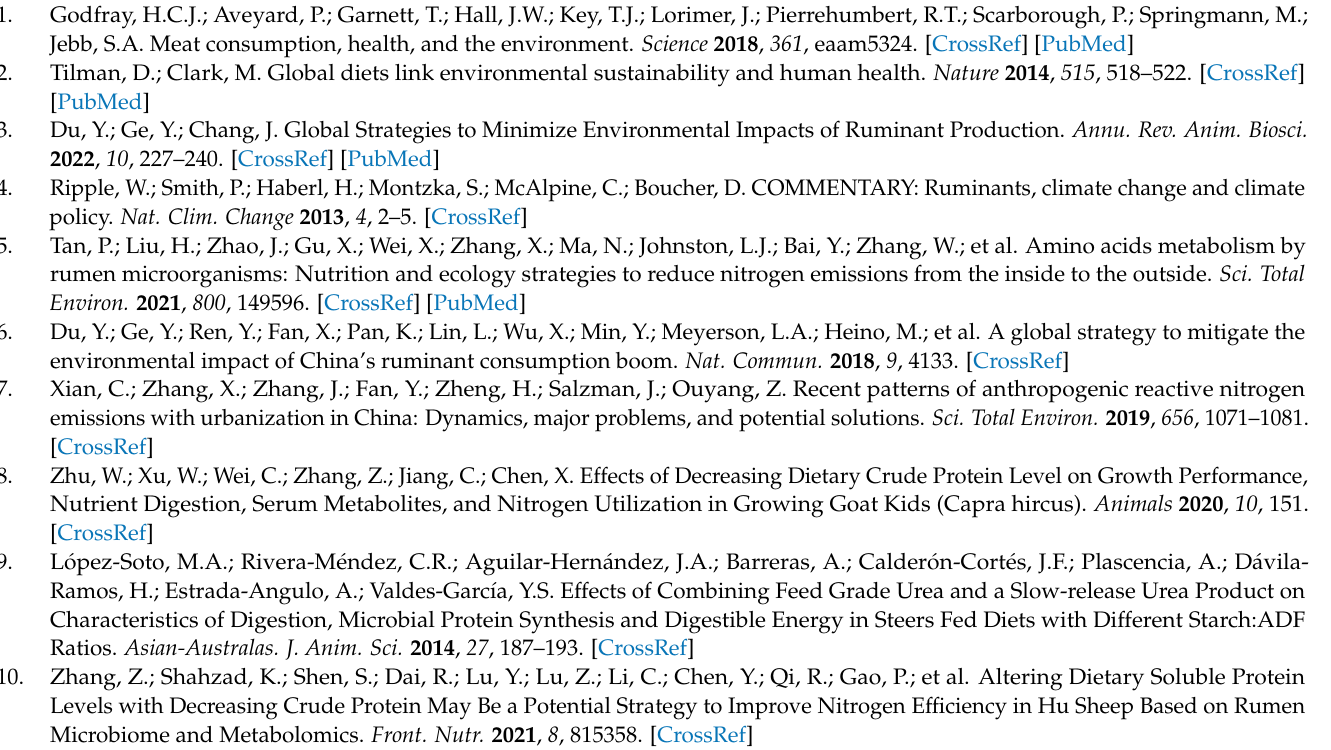
Table S2: Trend analysis of each treatment’s NH 3 -N content at different time points in